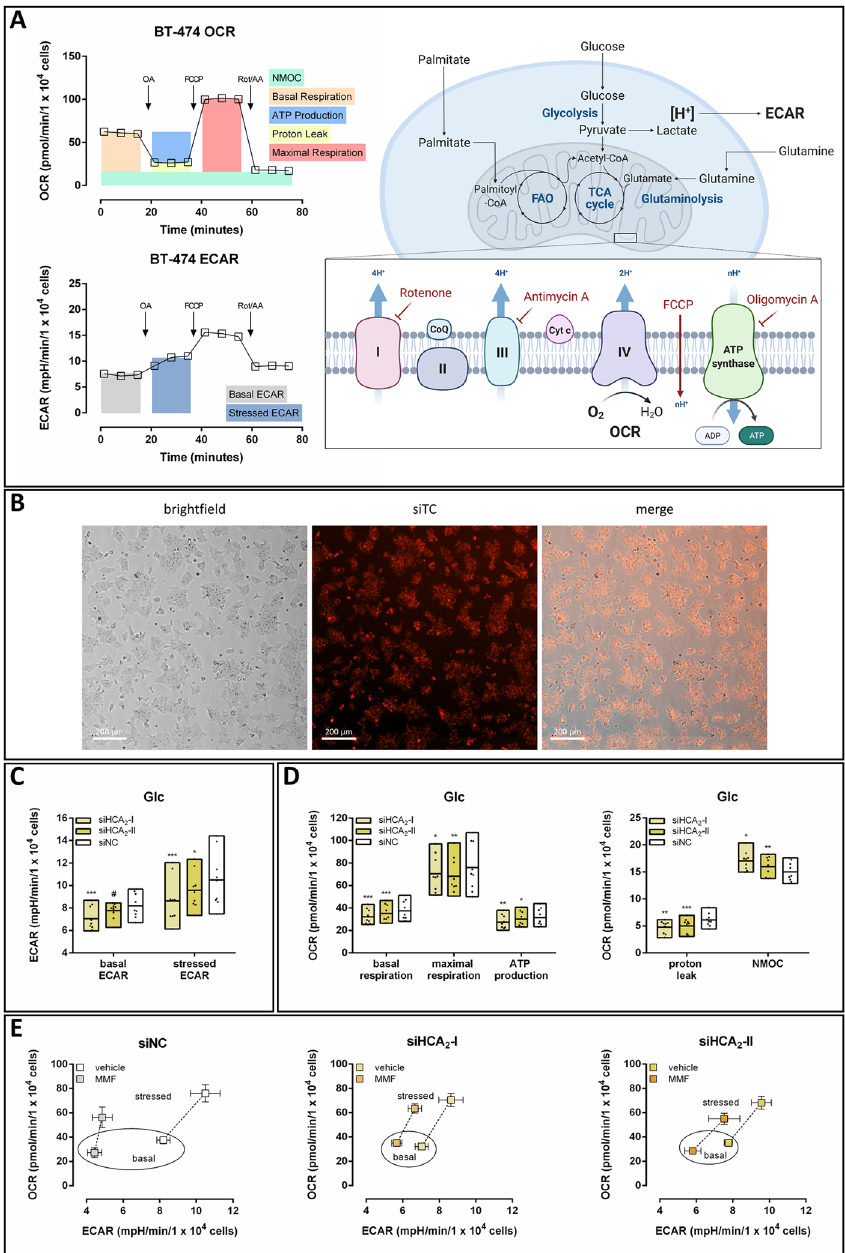
Fig. 1 Knockdown of HCA was accompanied by a decrease in mitochondrial respiration and ECAR in BT-474 cells with glucose as the only 2 energy substrate. A The oxygen consumption rate (OCR) and extracellular acidification rate (ECAR) of BT-474 cells were measured using a Sea- horse XFe96 Analyzer. With the help of specific inhibitors of the electron transport chain, different parameters of mitochondrial respiration and non-mitochondrial oxygen consumption (NMOC) were determined. B BT-474 cells were transfected with fluorescently labeled siRNA (siTC), and images were taken 24 h after transfection to determine siRNA transfection efficiency. C–E 24 h after BT474 cells were transfected with siNC or two different HCA -specific siRNAs (siHCA -I; siHCA -II), OCR and ECAR were measured in the presence of glucose (Glc). Knockdown of 2 2 2 HCA caused a decrease in C ECAR as well as D basal and maximal respiration, oxygen consumption coupled to ATP production and proton 2 leak. E The metabolic phenotype and potential (dotted line) of BT-474 cells were determined in the absence and presence of the HCA ago- 2 nist monomethyl fumarate (MMF). Stimulation with MMF caused an HCA -dependent shift to a less energetic phenotype. Data are shown as 2 mean ± SEM ( A , E ) or floating bars (min to max; C , D ) of three time points of three independent experiments, each carried out in six technical replicates. Statistical analyses were performed using repeated measures one-way ANOVA. # P ≤ 0.1; *P ≤ 0.05; **P ≤ 0.01; ***P ≤